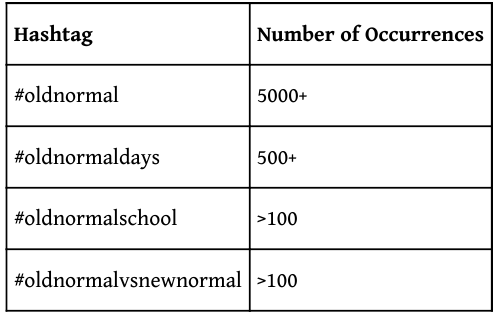
Table 2: Chosen hashtags under the basetag #oldnormal